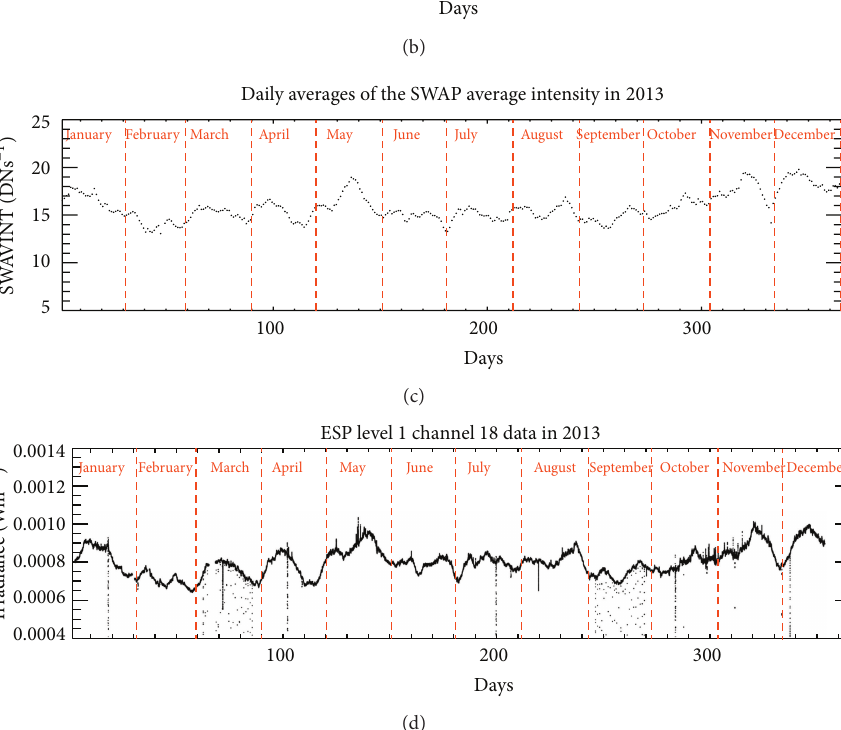
Figure 4: From top to bottom: LYRA level 3 channel 2–4 and ESP level 1 data (at combined responses of the channels QD and 18); LYRA channel 2–4 data alone; daily averages of SWAVINT data; and ESP channel 18 data variations in